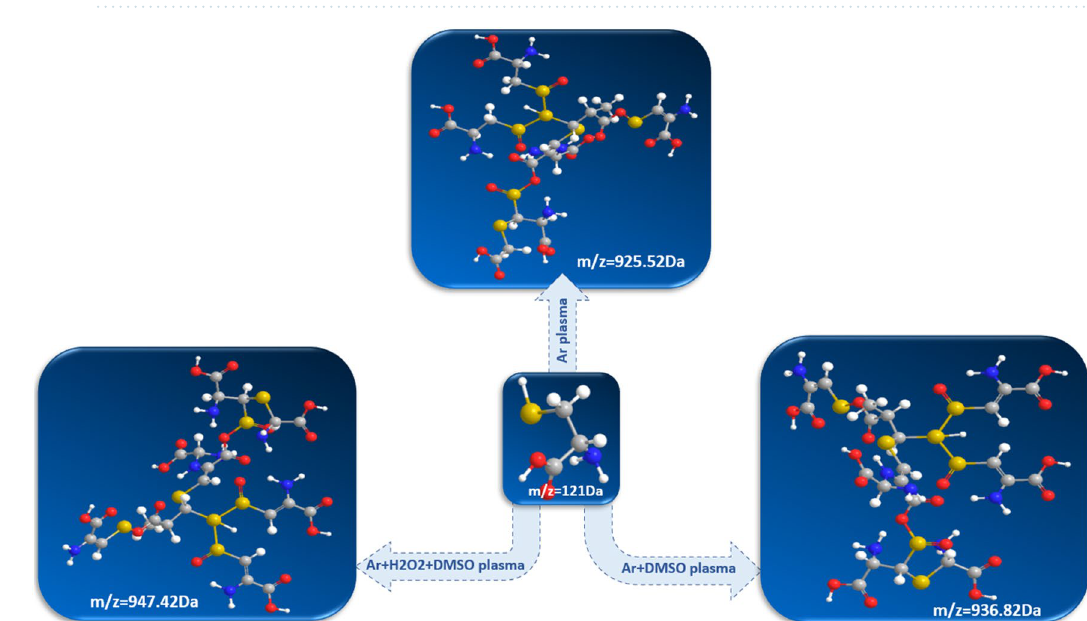
Figure 6. Abundance comparing of m/z = ( a )794 Da, ( b )405 Da, ( c )347 Da, ( d )336 Da, ( e )102 Da, ( f )77 Da.